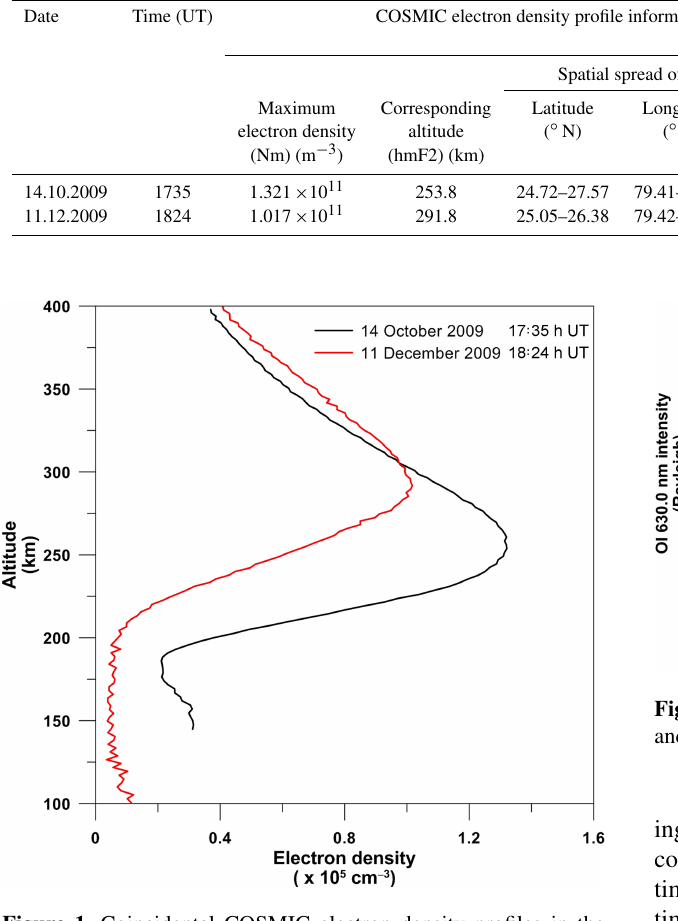
Figure 1. Coincidental COSMIC electron density profiles in the latitude–longitude grid of 5 ◦ × 5 ◦ centred over Allahabad (25.5 ◦ N, 81.9 ◦ E) on 14 October and 11 December 2009.